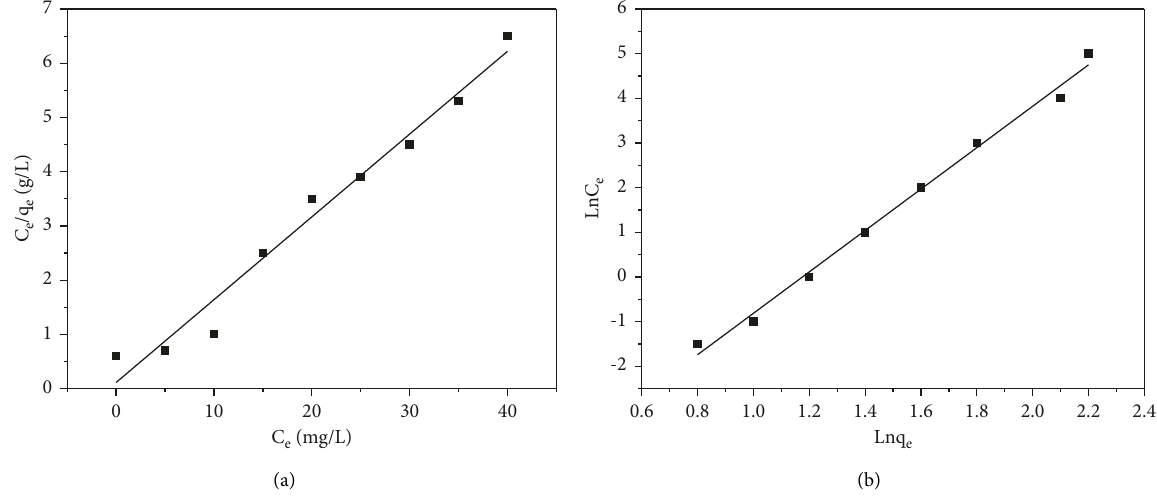
Figure 14: Langmuir (a) and Freundlich (b) isotherm modeling of fluoride adsorption onto GO.